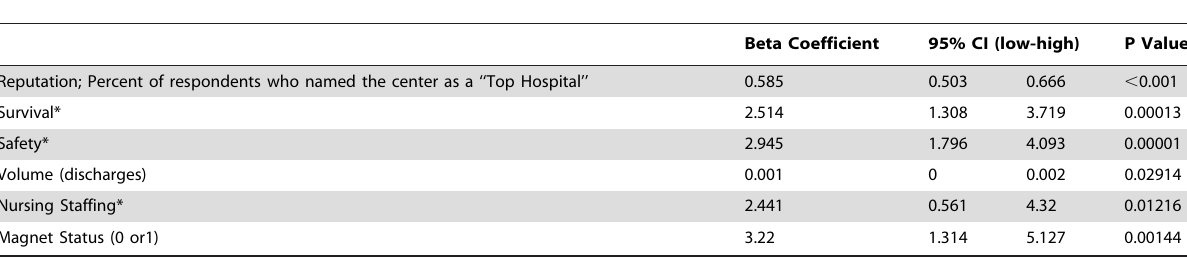
Table 2. A multiple linear regression of the US News and World Report Score and its contributors.